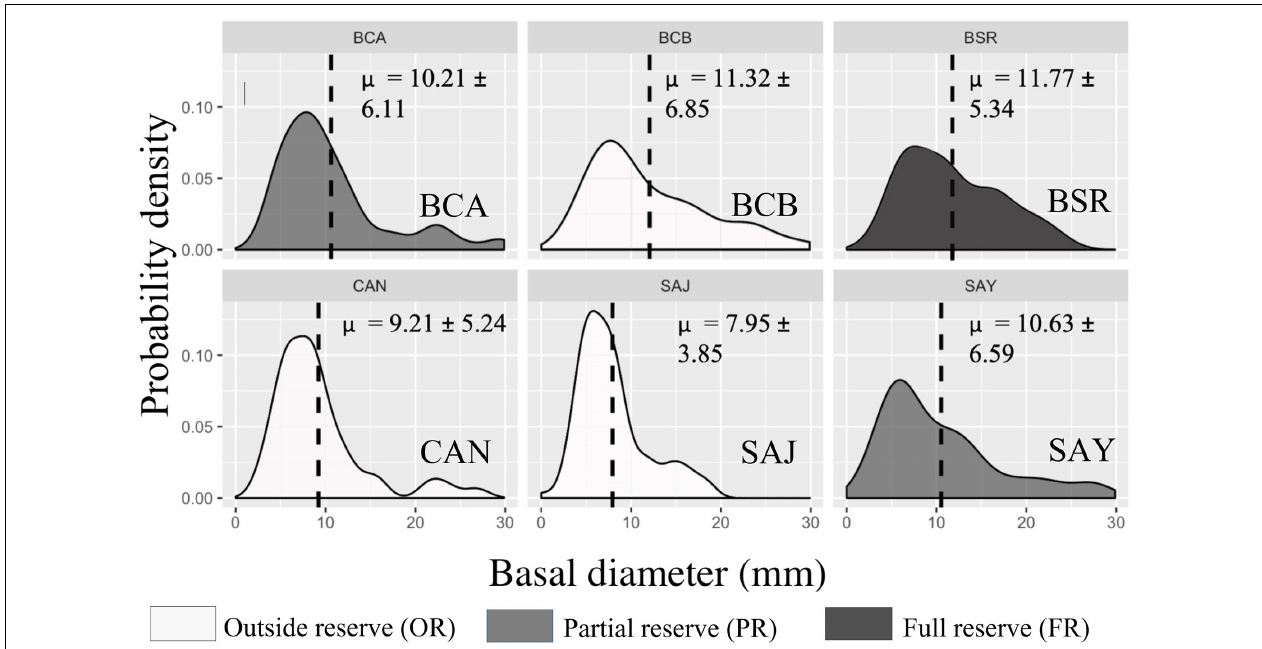
FIGURE 2 | Cerbère-Banyuls reserve: representation of probability density functions by population of each site for the basal diameter variable (mm) in 2020. The values indicated correspond to the means followed by the standard deviations. In dark the population in full reserve (BSR), in medium the populations in partial reserve (BCA, SAY), in clear the populations outside the reserve (BCB, CAN, SAJ).